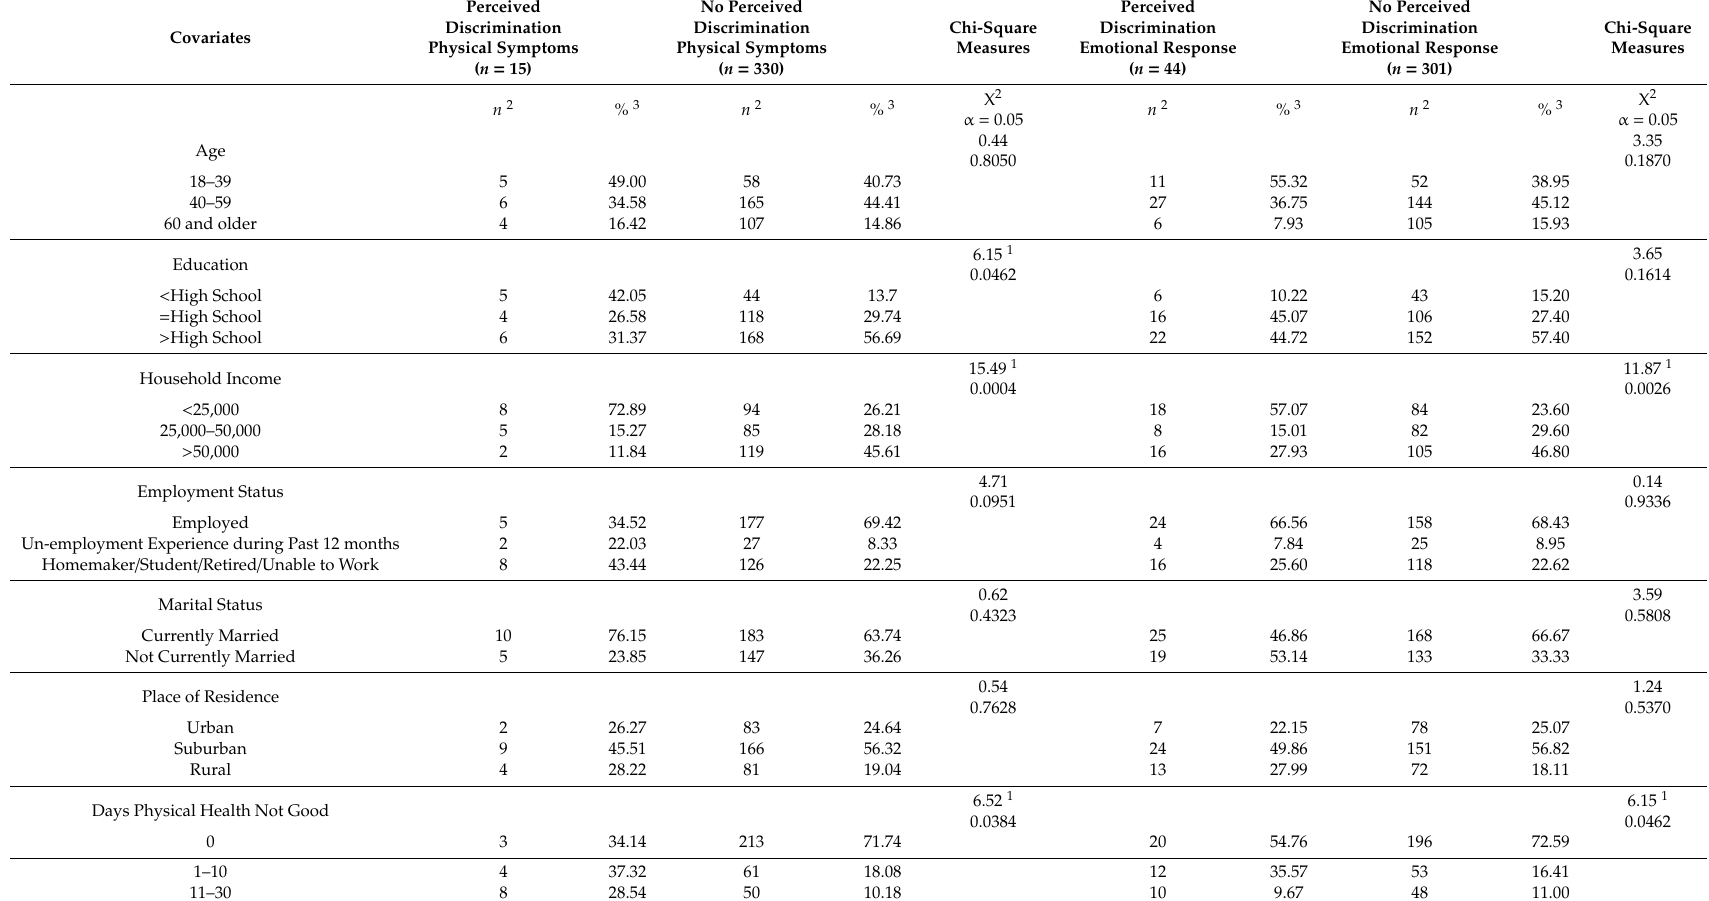
Table 2. Weighted Chi-square analysis of the characteristics of African American (AA) men in the southeastern United States by experiences of perceived discrimination at work, Behavioral Risk Factor Surveillance System (BRFSS)